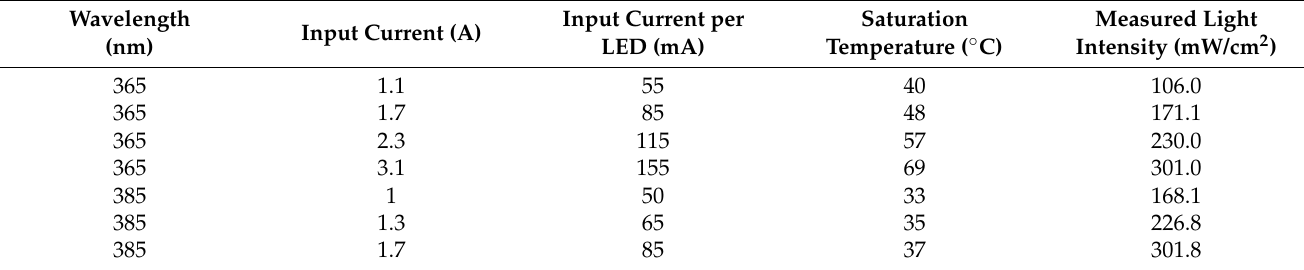
Figure 2. Prototype of the UV-LED module with a heat sink. Table 1. Light intensities per unit area and surface temperature of UV-LEDs at some input currents.